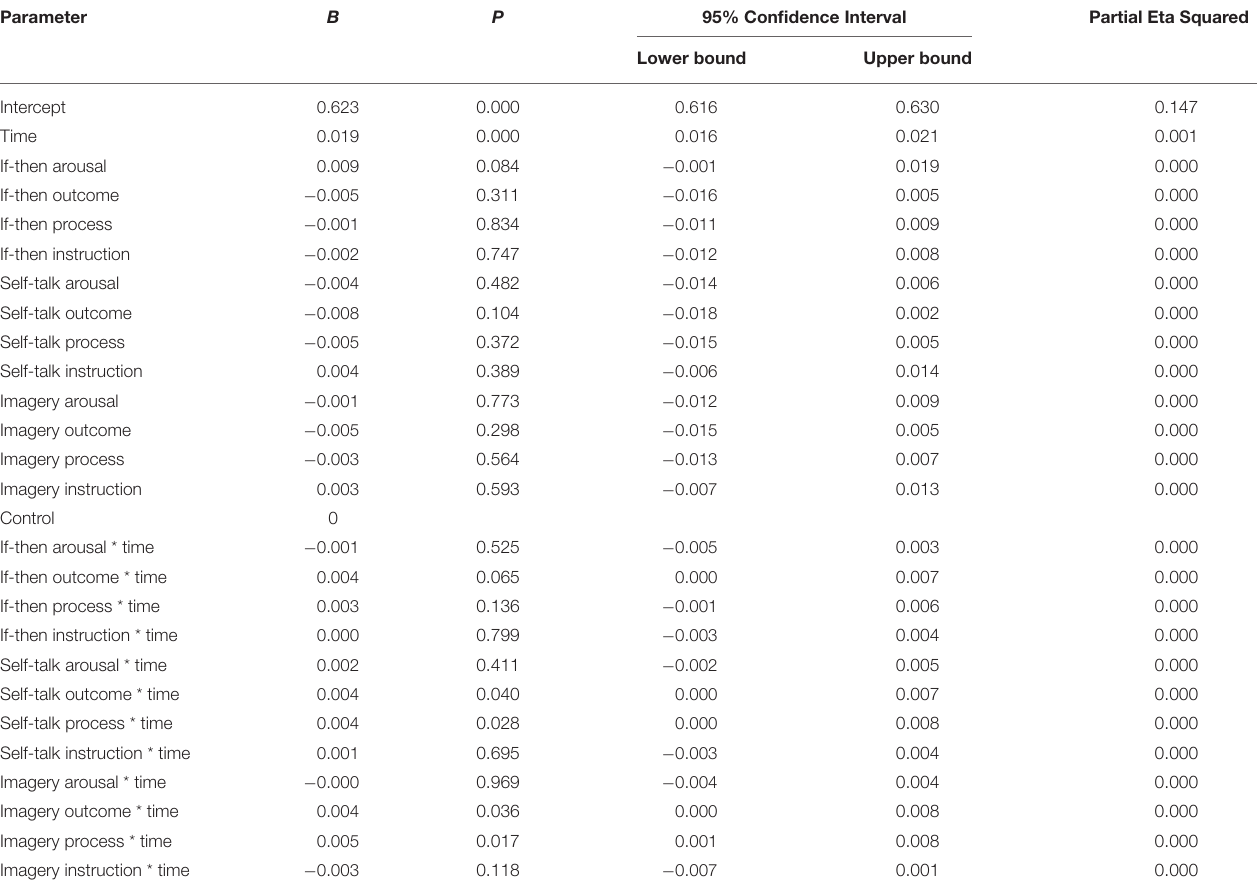
TABLE 3 | Analysis of covariance analysis of changes in performance by psychological